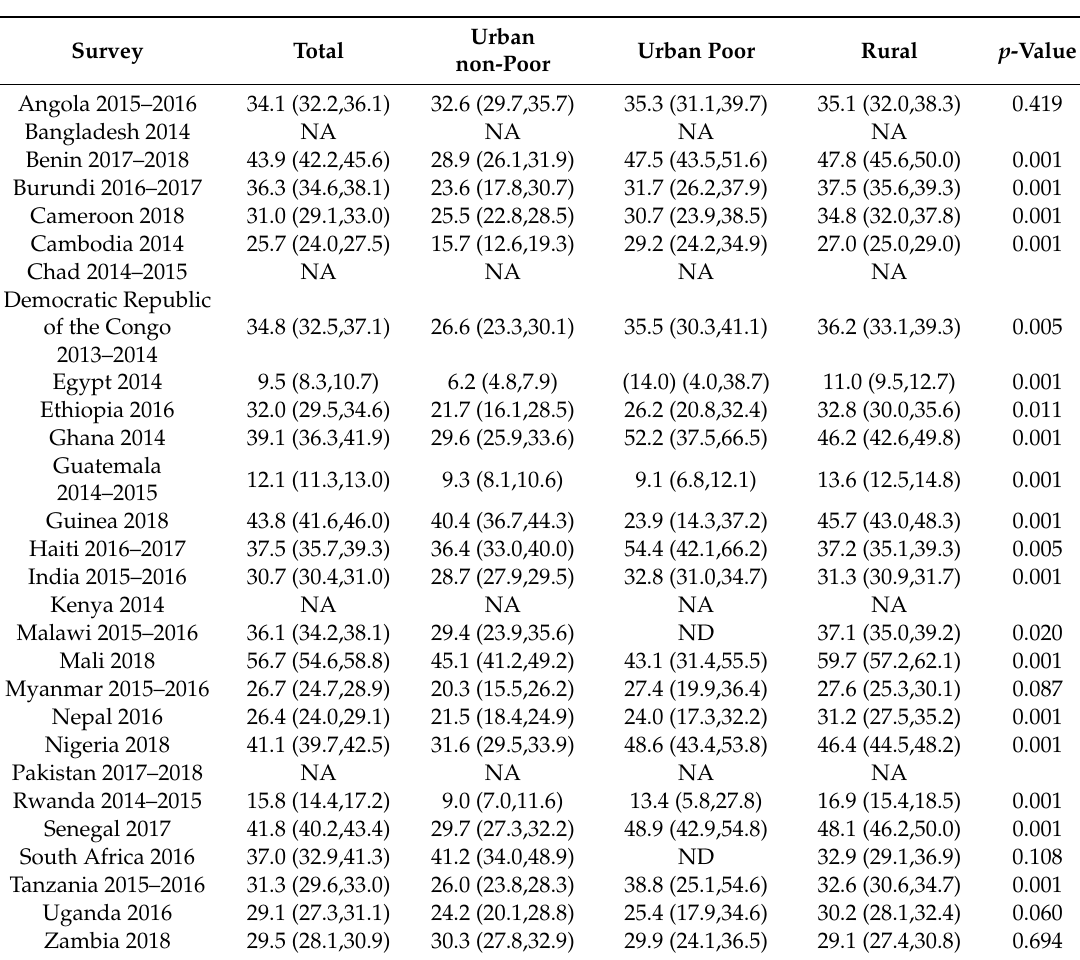
Table 3. Percentage and 95% CI of children age 6–59 months with moderate or severe anemia with crosstabulation by urban poverty cluster